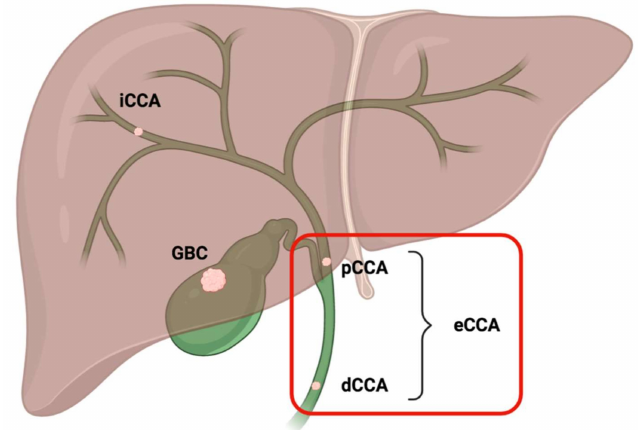
Figure 1. Schematic representation of the anatomical subgroups of biliary tract cancers. Extrahepatic cholangiocarcinoma includes the two subcategories of perihilar cholangiocarcinoma and distal cholangiocarcinoma; eCCA: extrahepatic cholangiocarcinoma; dCCA: distal cholangiocarcinoma; pCCA: perihilar cholangiocarcinoma; iCCA: intrahepatic cholangiocarcinoma; GBC: gallbladder